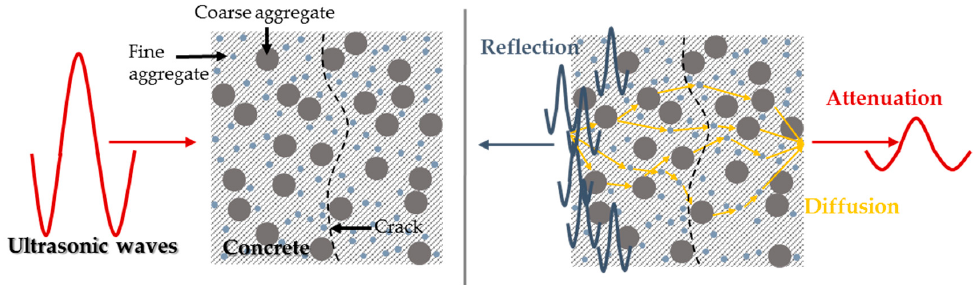
Figure 1. Diffusion phenomena of high-frequency ultrasound in concrete [21].